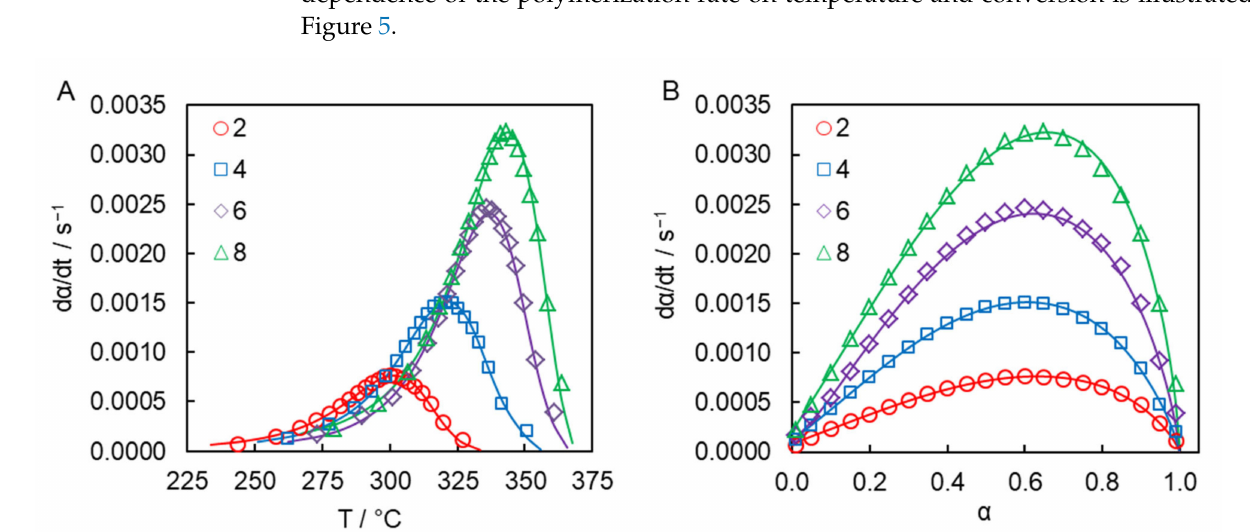
Figure 5. d α /dt vs. T ( A ) and d α /dt vs. α ( B ) experimental data (markers) and best fits to the Kamal model (solid lines) for the solution polymerization of dicyanate ester (numbers denote heating rates in ◦ C min − 1